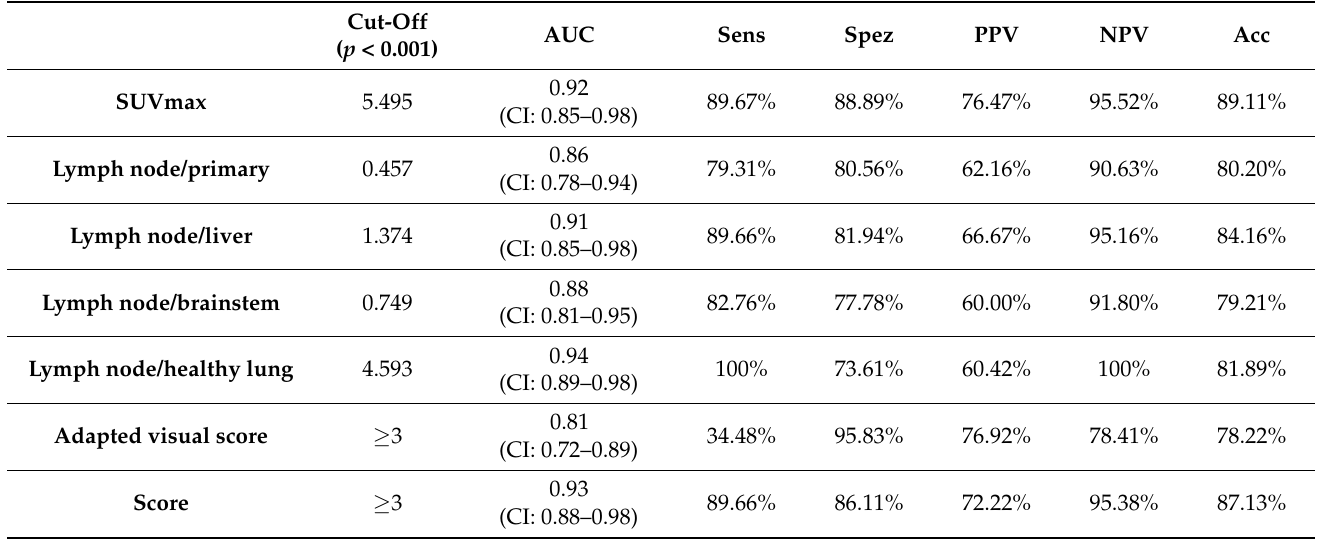
Table 3. ROC analyses and diagnostic performance of the above ratios and scores.